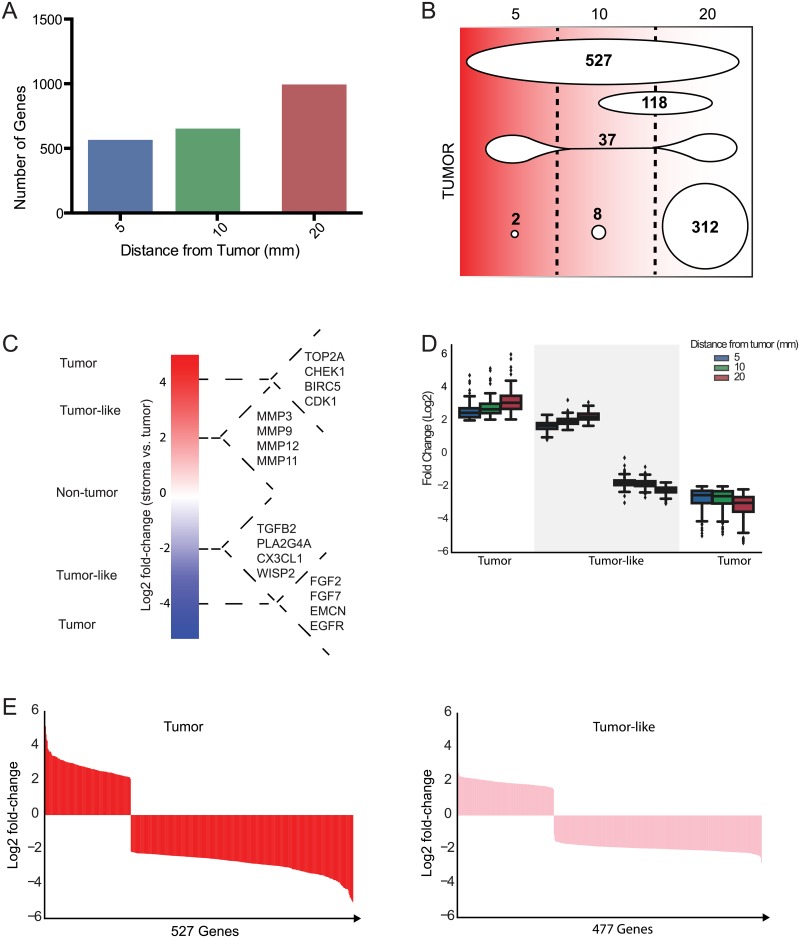
Derivation of a tumor-like stromal gene signature.(A) The number of differentially expressed genes when comparing tumor (0 mm) vs. 5 mm, vs. 10 mm, and vs. 20 mm of cancer-free stroma. (B) Gene lists from 5, 10, and 20 mm of stroma were compared for overlap in gene expression identity. Gene expression in the intersect of all gene lists (527) comprises the tumor gene expression signature, while gene expression in the union of the gene lists excluding the intersect comprise the tumor-like gene expression signature (bottom). (C) Schematic representation of data demonstrating segregation of gene expression as non-tumor, tumor-like, and tumor. (D) Trends in fold-change of tumor and tumor-like gene expression across distances. (E) Log2 fold change of entire gene list for tumor or stroma tumor-like genes showing the breadth of change represented by the width of displayed gene change patterns.